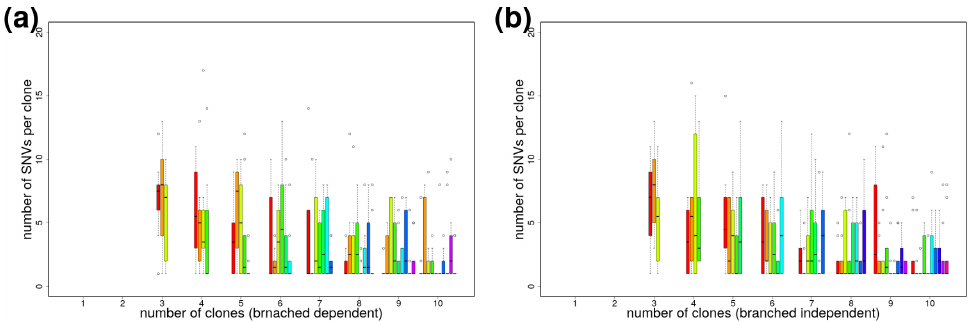
Figure A6. Boxplots showing the number of SNVs per cluster considering different numbers of clones. ( a ) Branched dependent evolution and ( b ) branched independent